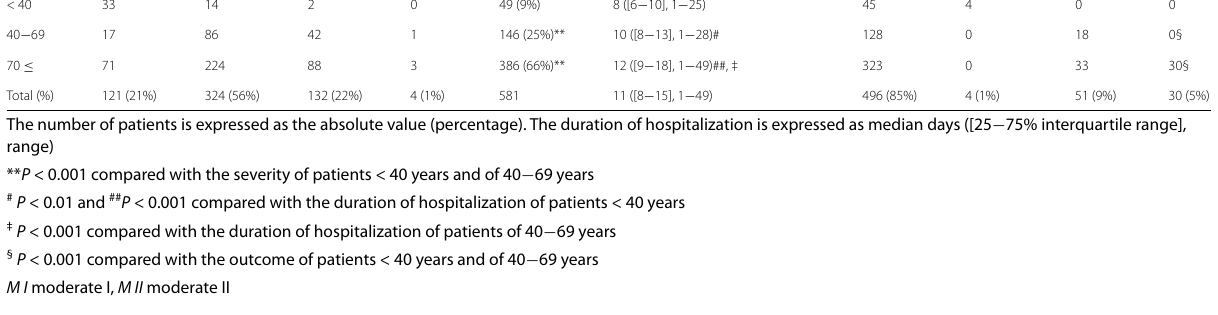
Table 3 Symptoms on admission and comorbidities